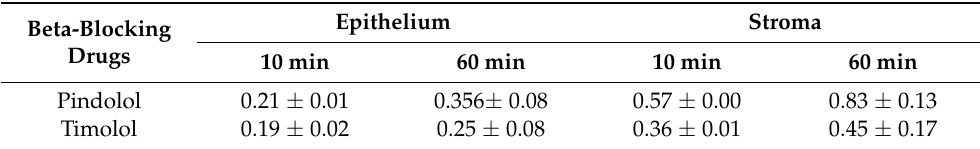
Table 2. Ratios of pindolol and timolol signals against twice the signal of propranolol in rabbit corneal epithelium and stroma after eye drop